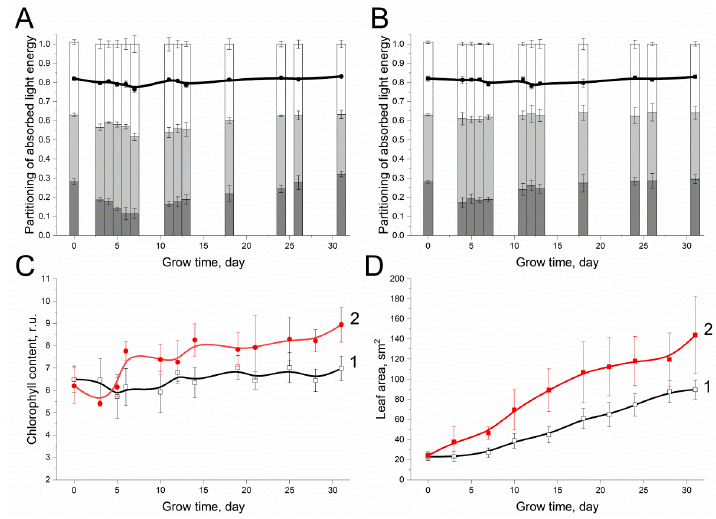
Figure 2. Dependence of the partitioning of absorbed light energy on the growth time of plants under glass coated with fluoroplate polymer with ( A ) or without ( B ) photoconversion nanoparticles. Effective quantum yield of PSII (Y(II)), quantum yield of light-induced non-photochemical quenching of ChlF (Y(NPQ)) and quantum yield of non-regulated heat dissipation and fluorescence emission (Y(NO)) are shown in dark gray, light gray and white, respectively. The black line indicates the maximal quantum yield of the photosystem II photochemistry. Dependence of relative chlorophyll content ( C ) and total area ( D ) of leaves on the growth time of plants under glass coated with fluoroplate polymer without (1) or with (2) photoconversion nanoparticles. The data are the means of at least 11 measurements, with the standard error of the mean. Relative chlorophyll content value is the mean of 4 – 10 measurements on at least 11 plants. It was shown that the proportion of Y(II) decreased within the first days of the ex- periment and then was gradually restored to the initial values in the leaves of both plant groups. In the control plants, Y(II) drastically reduced within the first week from 0.28 to 0.11 (Figure 2B) and afterward increased slowly and reached the initial values by the end of the fourth week of the experiment. In contrast to the control plants, the tomatoes grown under the PCF demonstrated a relatively small decrease in Y(II) (from 0.28 to 0.19 within three – four experimental days), and a rapid restoration of Y(II) that reached the